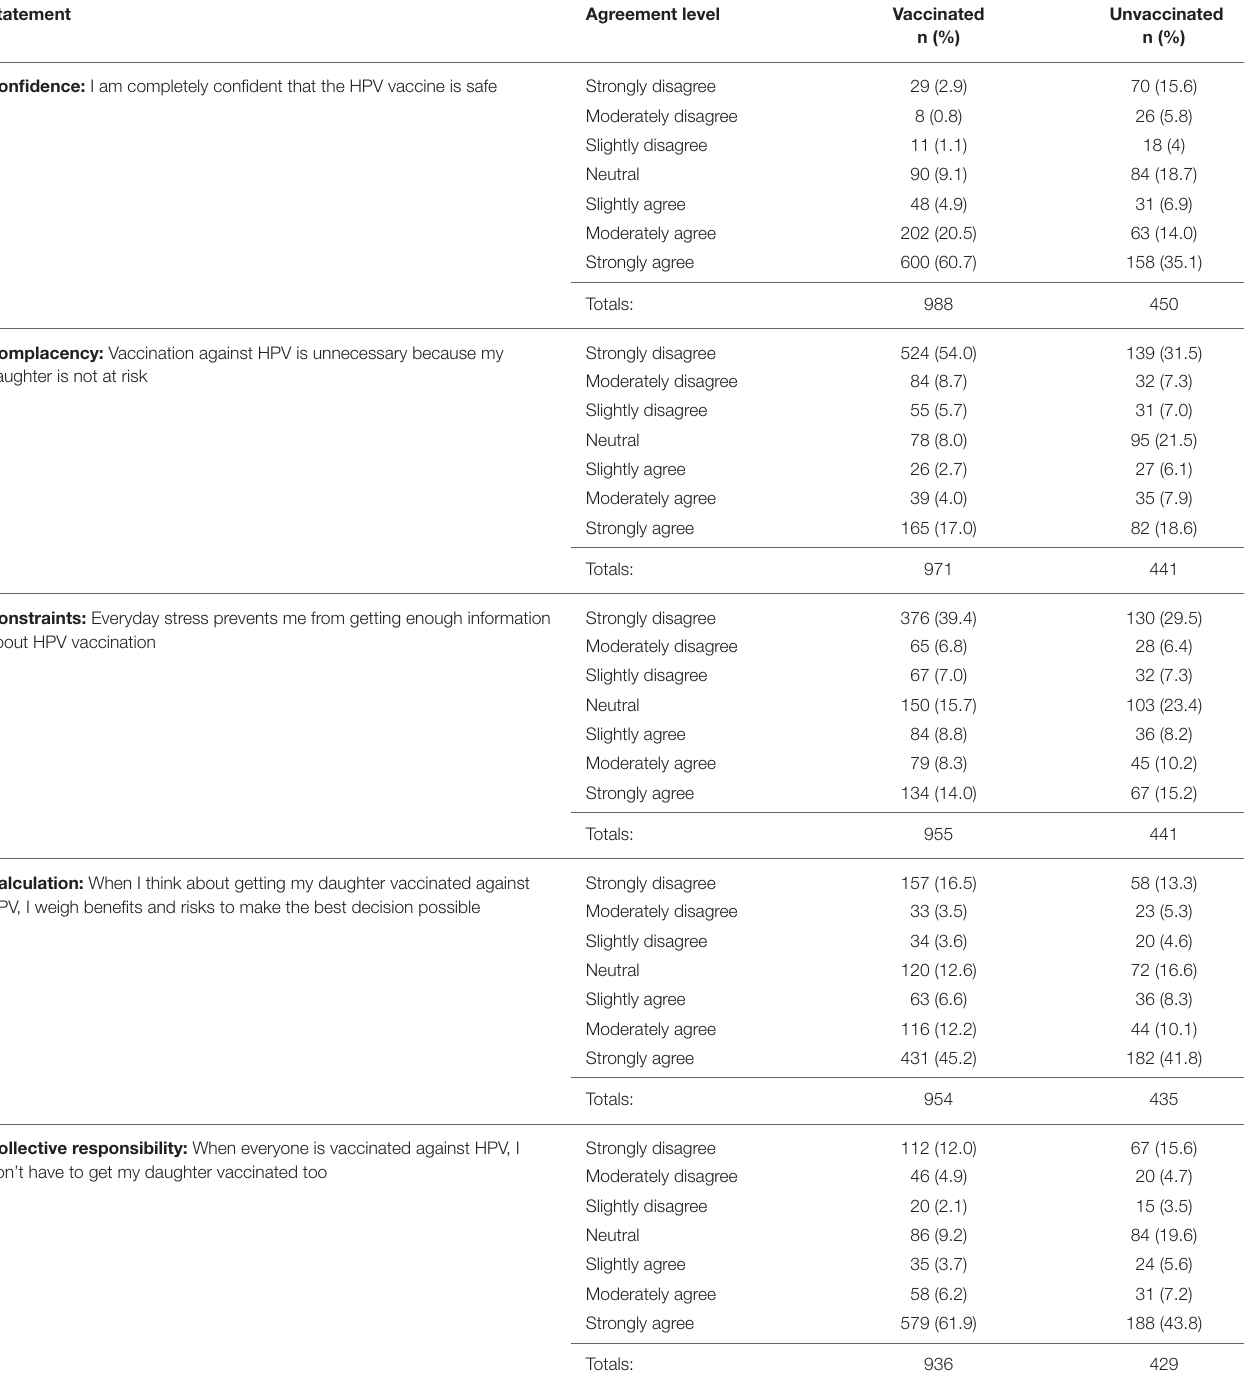
TABLE 5 | Frequency distributions of all responses to the 5C